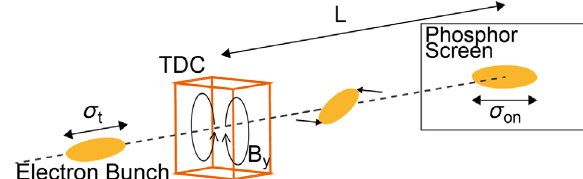
FIG. 2. Principle of the bunch length measurement. The vertical magnetic field streaks the electron bunch horizontally. TDC: transverse deflecting cavity.